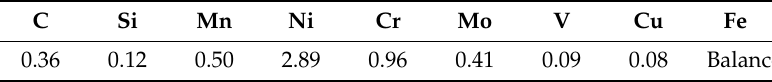
Table 1. Chemical composition of the AISI 4340 workpiece (wt.%).